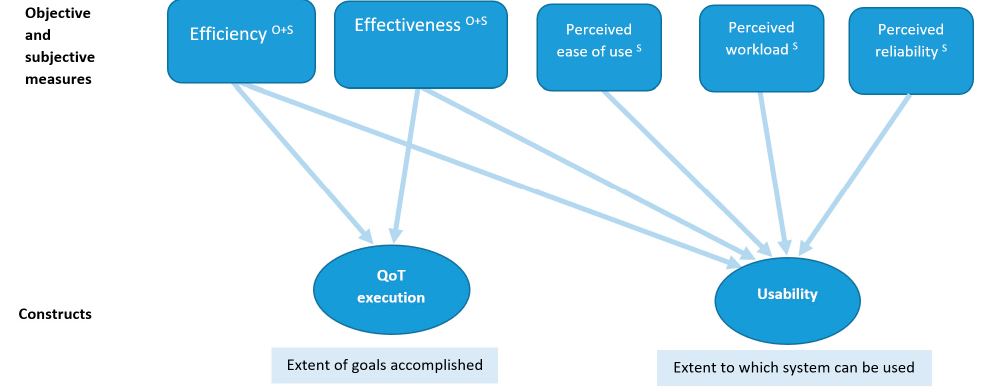
Figure 6. Mapping of the measures into constructs for assessment. (O—objective measures; S—subjective measures).